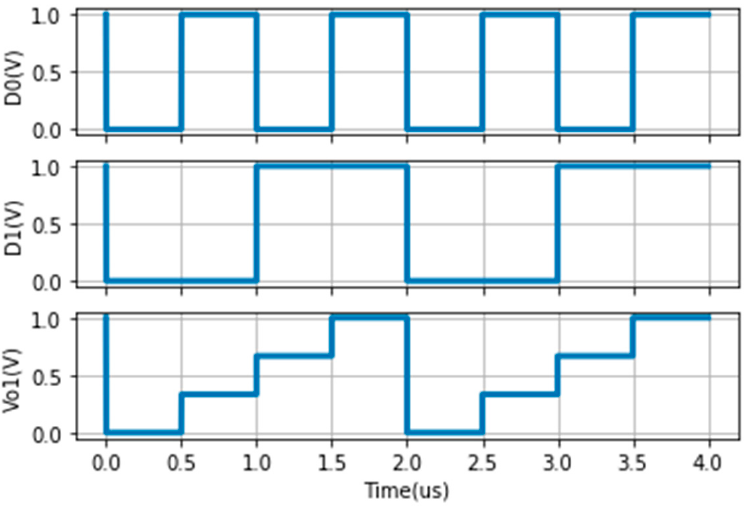
Figure 13. Simulation of a 2 bit binary-weighted DAC cell.